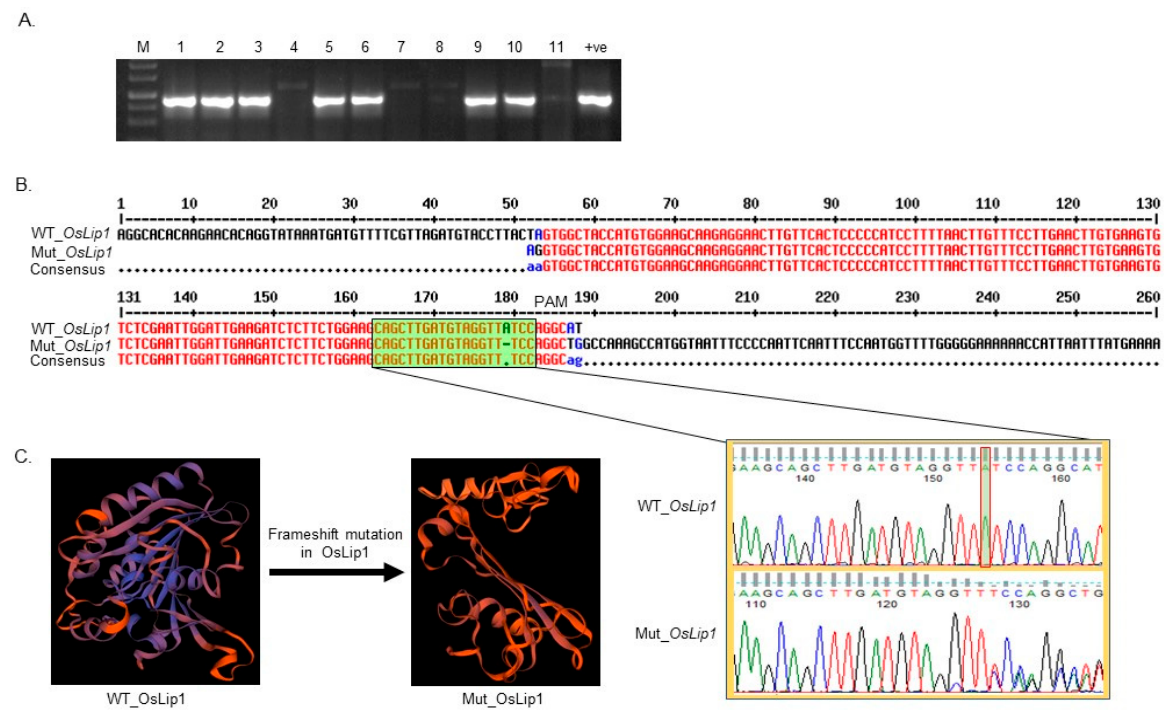
Figure 2. Schematic representation of CRISPR/Cas9-mediated targeted mutagenesis in the OsLip1 (LOC_Os11g43510) gene. ( A ) Identification of transgenic rice plants carrying the Cas9 transgene, with a sgRNA targeting the OsLip1 gene. Genotyping was performed using the OsLip1 -specific sequencing primers. ( B ) Sequence alignment and sequencing chromatogram at the target site of OsLip1 in the edited plants (T0). The vertical box indicates the deletion mutation (Mut) of adenosine ( A ) in the OsLip1 gene. ( C ) Frameshift mutation distorted the overall protein structure of OsLip1. WT; wild-type.